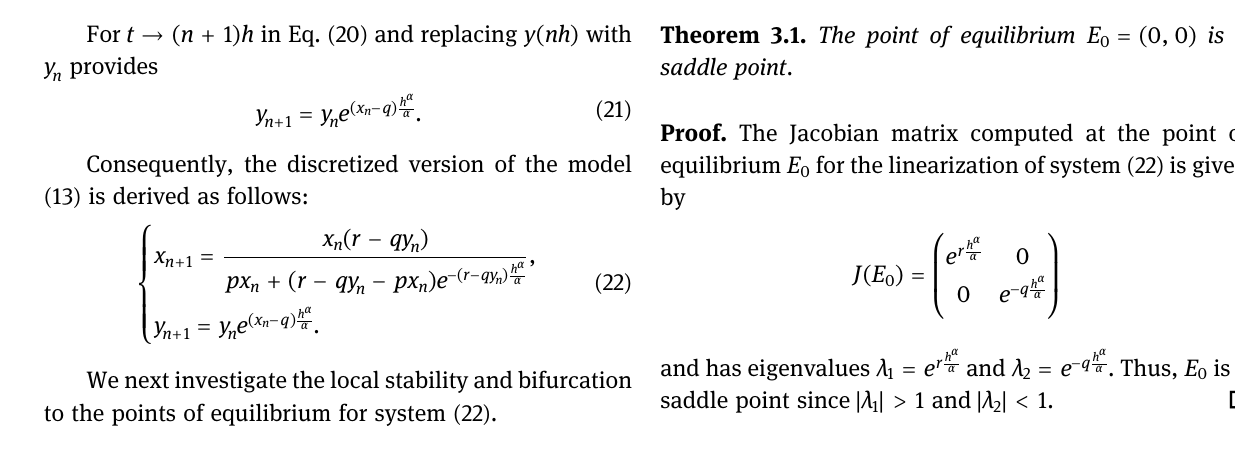
Figure 4: Stable dynamical behavior of system ( 22 ) subject to the initial condition ( ( ) ( )) ( ) = x y 0 , 0 0.25, 0.2 for the parameters = = = p q α 0.5, 1, 0.95, and = r 1 : ( a ) = h 0.15 , ( b ) = h 0.35 , ( c ) = h 0.55 , and ( d ) = h 0.75